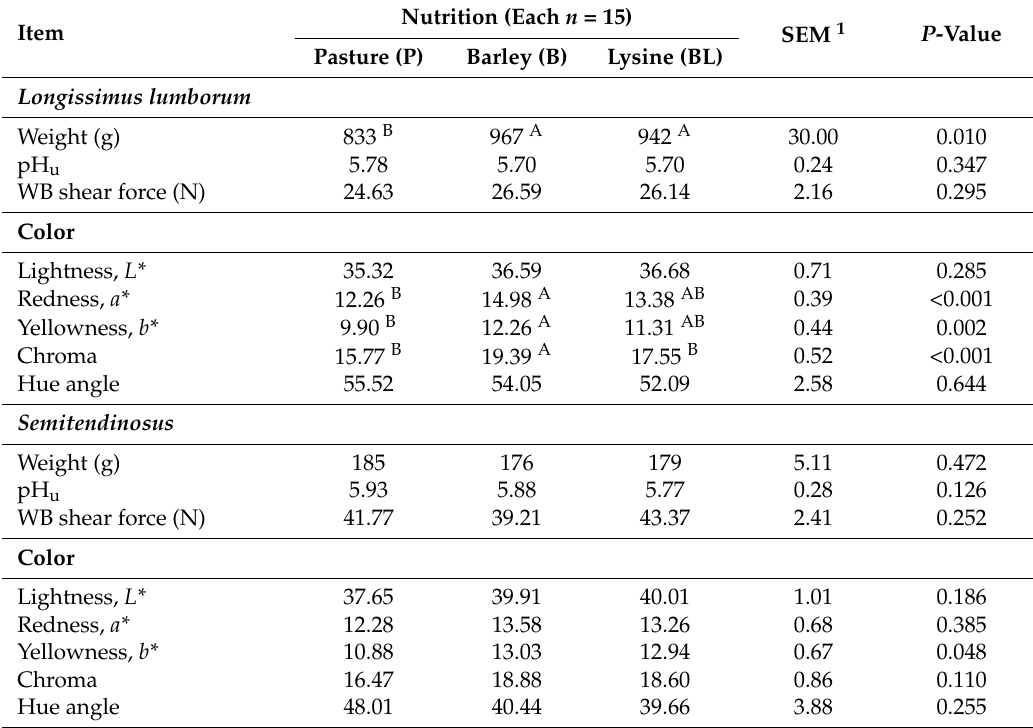
Table 4. Physical characteristics of longissimus lumborum and semitendinosus muscles from fallow deer bucks ( n =